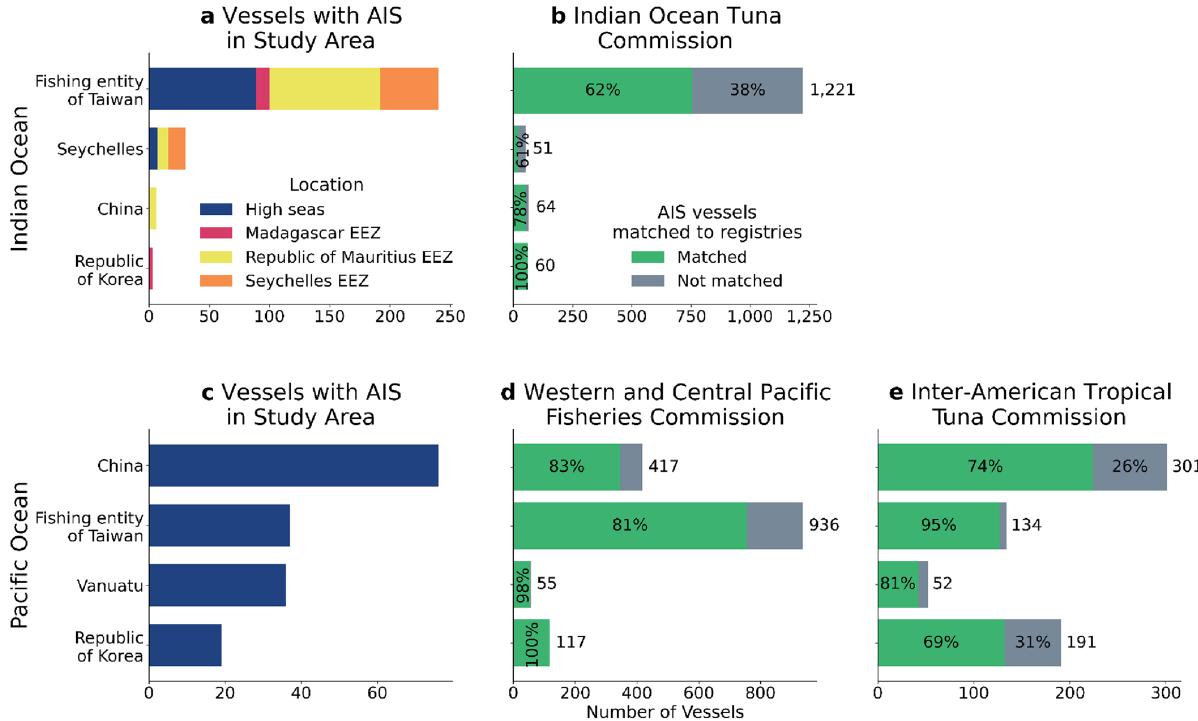
Figure 2. Regional fisheries management organization (RFMO) registries, matched to AIS data, suggest that 0–61% of the key fleets vessels are not broadcasting AIS in each ocean basin. Flag states of fishing vessels with AIS in each region ( a and c ) and vessels registered to RFMOs ( b , d , e ). In the Indian Ocean region ( a ), vessels with AIS were present in five different exclusive economic zones (EEZs), while in the Pacific ( c ) All vessels